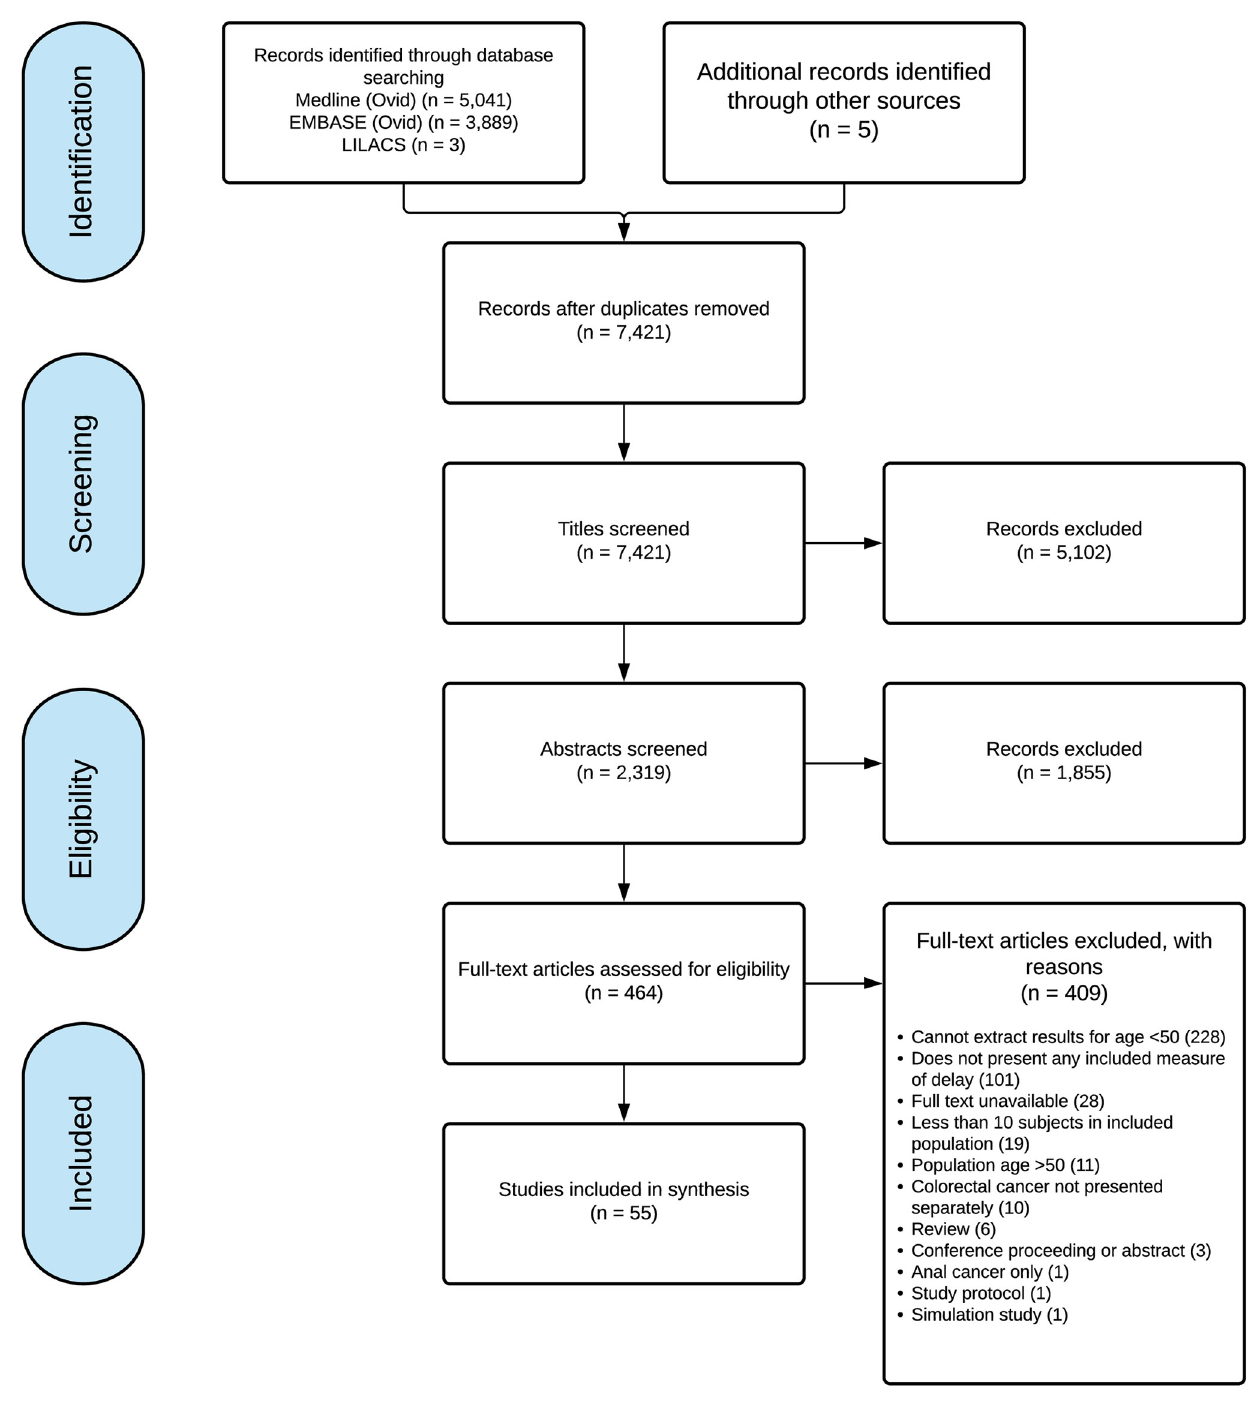
Fig 2. Preferred reporting items for systematic review and meta-analysis flow diagram of included studies.